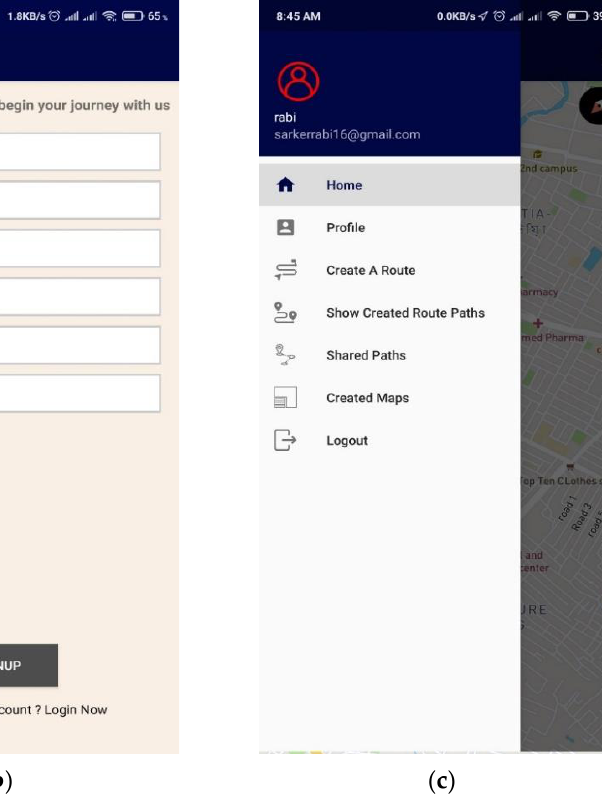
Figure 9. Application layout of Login ( a ), Sign up ( b ), and Profile ( c ).